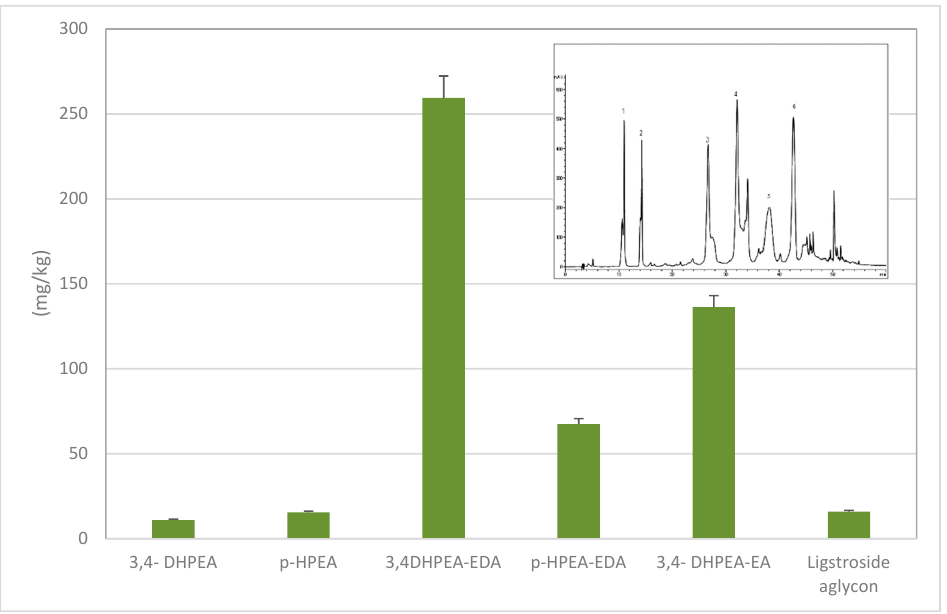
Figure 2. Concentrations of individual phenolic alcohols and secoiridoids in a typical EVOO, measured by HPLC-DAD analysis. The inset shows the chromatographic profile with the numbers on the top of the peaks indicating respectively: 3,4-DHPEA (1); p-HPEA (2); 3,4-DHPEA-EDA (3); p-HPEA-EDA (4); 3,4-DHPEA-EA (5); ligstroside aglycon (6). The mobile phase was water and 0.2% acetic acid (solvent A) and methanol (solvent B); the flux was 1 mL/min. The elution gradient was made as follows: 95% A/5% B for 2 min, 75% A/25% B for 8 min, 60% A/40% B for 10 min, 50% A/50% B for 16 min, 0% A/100% B for 14 min; the latter gradient was kept constant for 10 min, to return at the initial phase. Adapted from Selvaggini et al . [9] and Antonini et al. [10]. The secoiridoids are produced in the secondary metabolism of the terpenes in the drupe pulp,